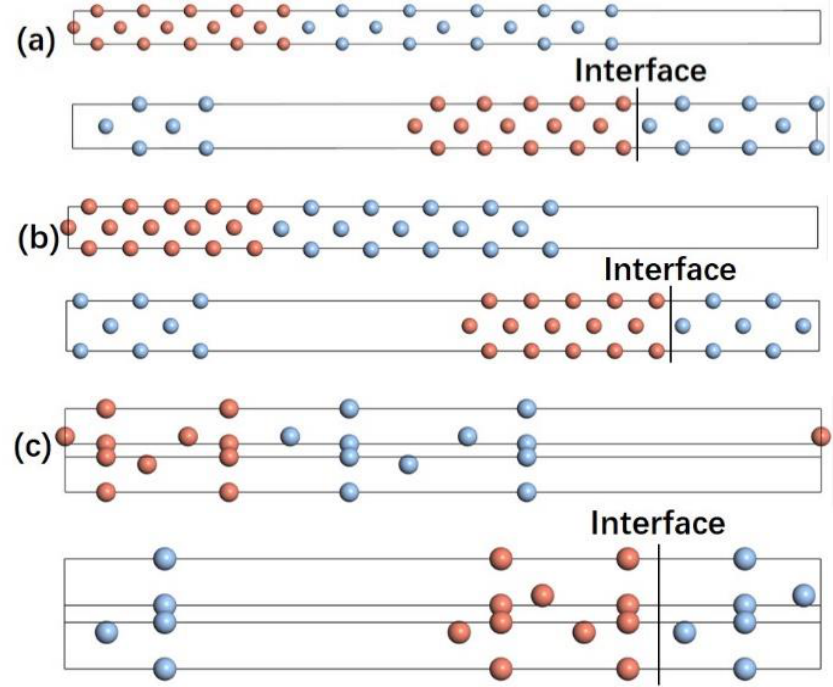
Figure2. ThestructuresoftheCu / Aginterface. ( a )Ag(100) / Cu(100);( b )Ag(110) / Cu(110);( c )Ag(111) / Figure 2. The structures of the Cu/Ag interface. ( a ) Ag(100)/Cu(100); ( b ) Ag(110)/Cu(110); ( c ) Ag(111)/Cu(111).